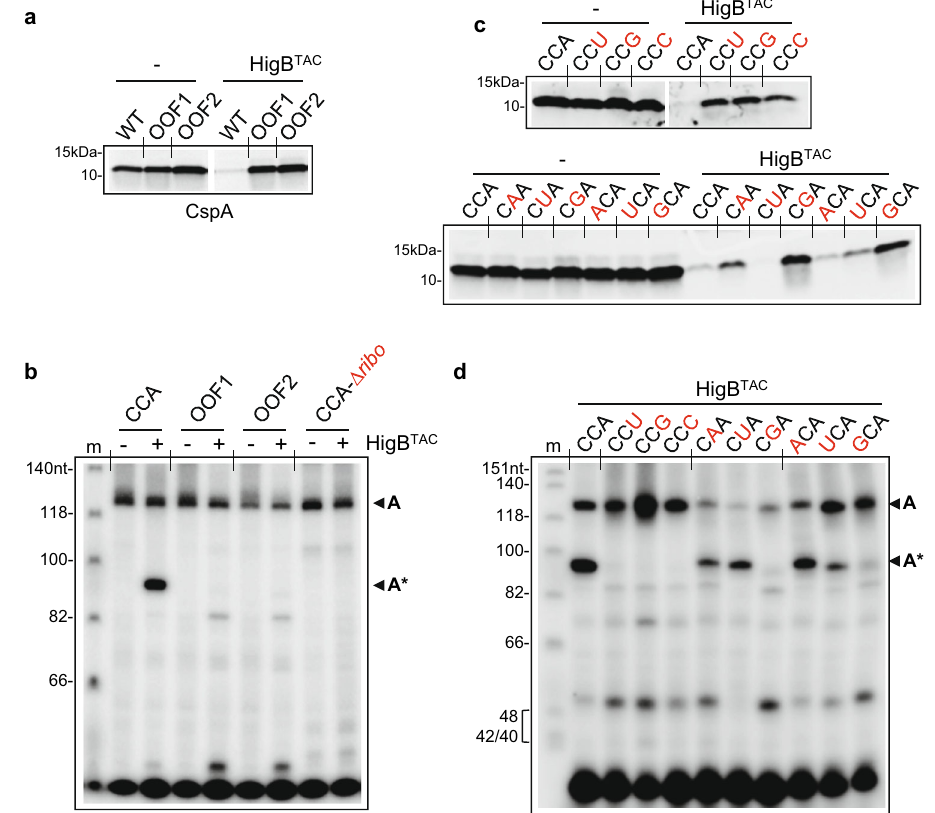
Fig. 3 HigB TAC cleaves cspA mRNA at CCA codon during translation in vitro. a HigB TAC inhibits synthesis of CspA wild-type (WT with codon CCA at Pro2) but not of CspA with + 1 (OOF1) and + 2 (OOF2) out of frame CCA motifs. CspA WT, OOF1, and OOF2 were independently expressed in a cell-free translation system with or without HigB TAC (1.5 µ M) as described in Fig. 1d. CspA translation products were labeled with [ 35 S]methionine and reactions were performed for 1 h 30 min at 37 °C. After translation, samples were separated on SDS – PAGE and visualized by phosphorimager. b Cleavage of cspA wild-type is ribosome-dependent. cspA wild-type (CCA), OOF1, and OOF2 were independently expressed in a cell-free translation system for 2 h with or without HigB TAC (1.5 µ M). RNA was extracted and subjected to a primer extension with [ 32 P]-labeled cspA primer. In parallel, cspA mRNA was incubated for the same time with or without HigB TAC (1.5 µ M) in the absence of ribosomes (CCA- Δ ribo ), and also used for primer extension. The obtained labeled cDNAs were separated on denaturing urea-polyacrylamide gel and revealed by autoradiography. Arrows show the uncleaved (A, 126 nt) and cleaved (A*, 95 nt) cspA , and (m) stands for molecular ladder. Mutations in the CCA codon prevent both inhibition of CspA synthesis ( c ) and cleavage ( d ) of cspA by HigB TAC in vitro. cspA wild type (CCA) and its mutant derivatives (mutations depicted in red) were independently expressed in a cell-free translation system with or without HigB TAC (1.5 µ M) and analyzed as described in panel ( a ) for CspA protein synthesis and in panel ( b ) for cspA